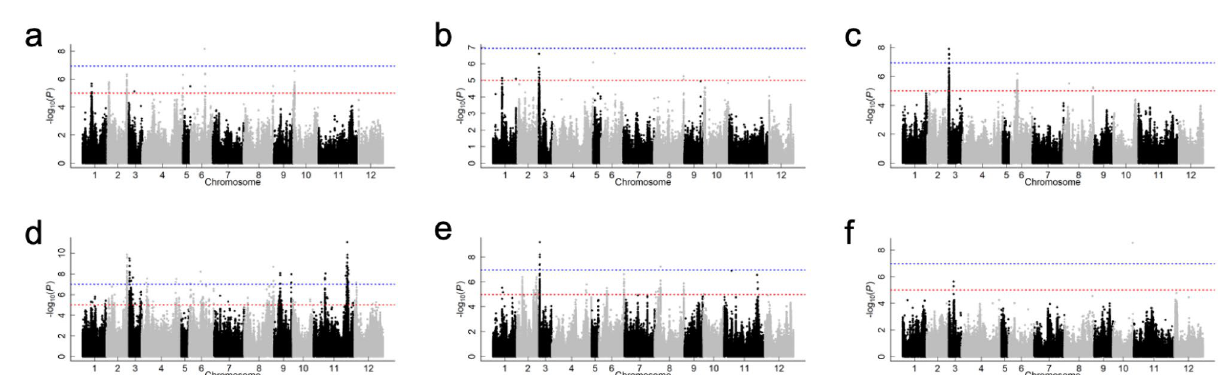
Figure 5. Manhattan plots of lodging resistance-associated traits. ( a ) ODMI in 2018; ( b ) BM in 2018; ( c ) culm length in 2018; ( d ) ODMI in 2019; ( e ) BM in 2019; ( f ) culm length in 2019. The x-axis indicates the SNPs or indels that physically mapped on each chromosome. The red and blue dashed lines indicate the threshold lines (− log 10 ( P ) = 5) set in this study and the Bonferroni correction, respectively. Manhattan plots were created using the package ‘rrBLUP’ 68 for R software (https:// www.R- proje ct. org/) 65 .